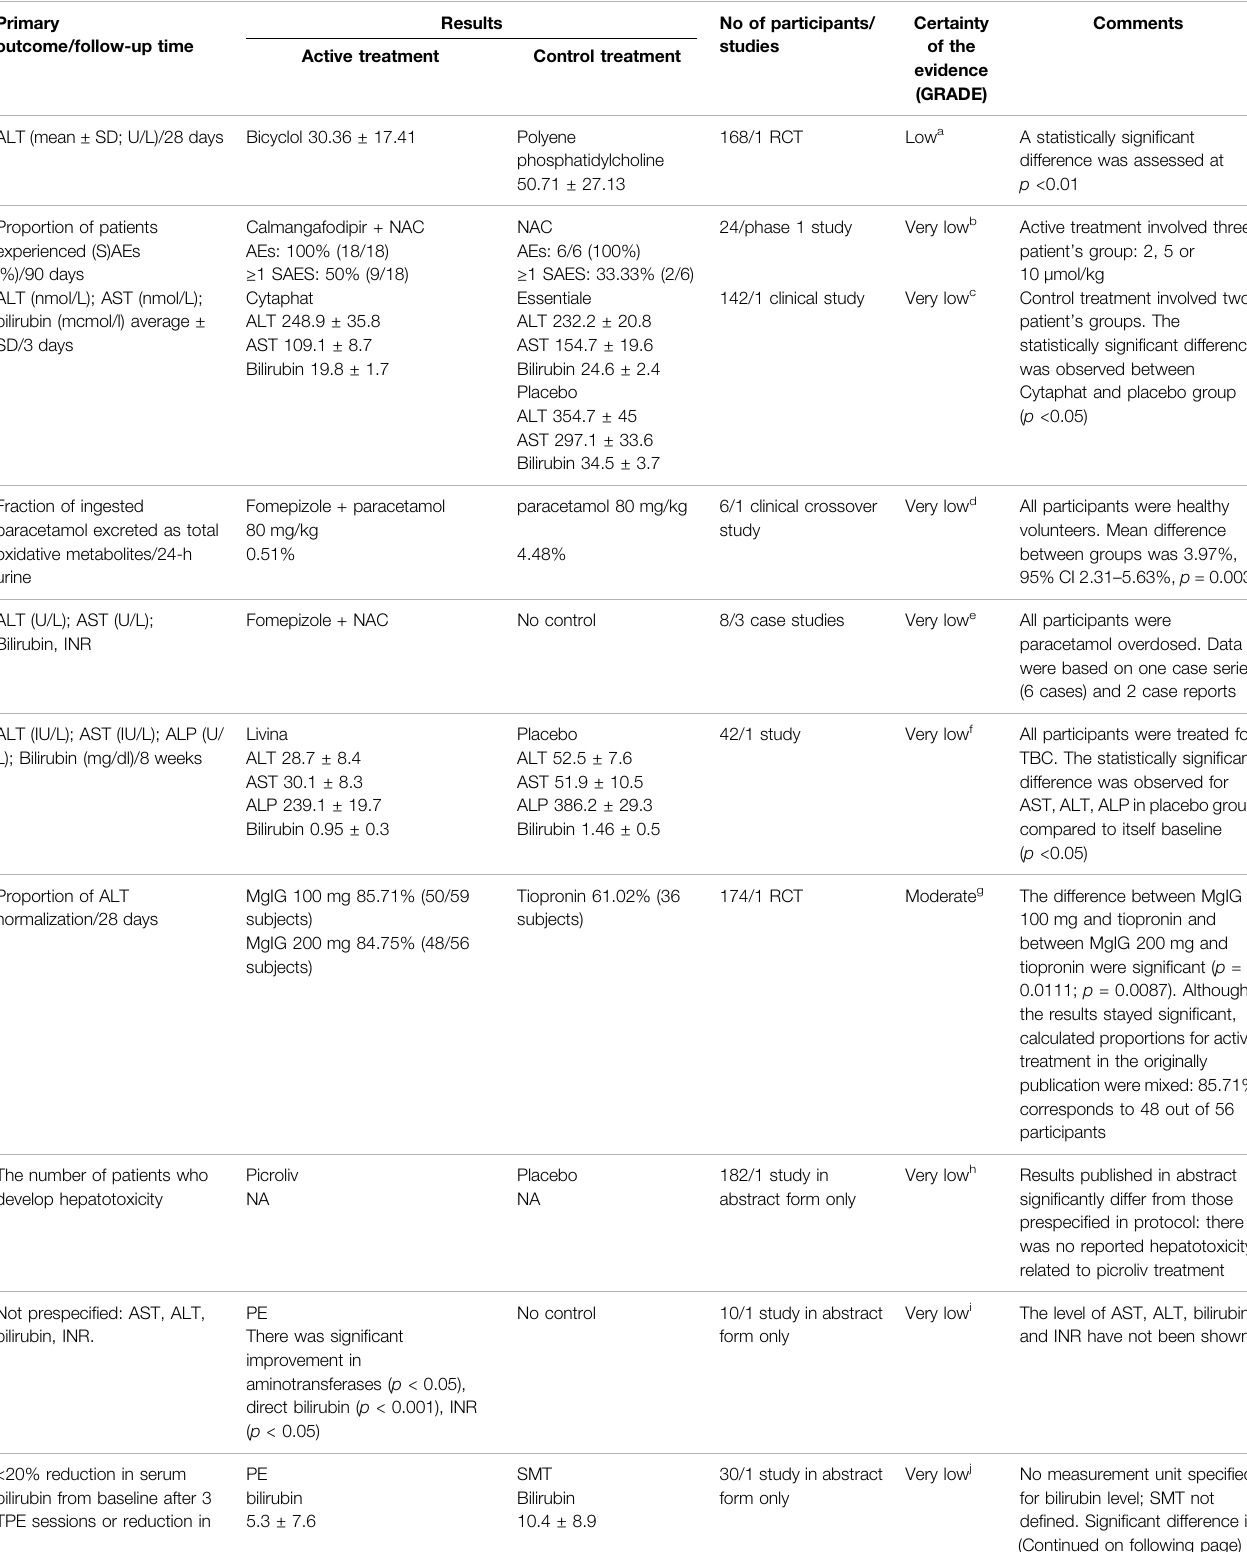
TABLE 4 | Summary of main outcomes and the certainty of the